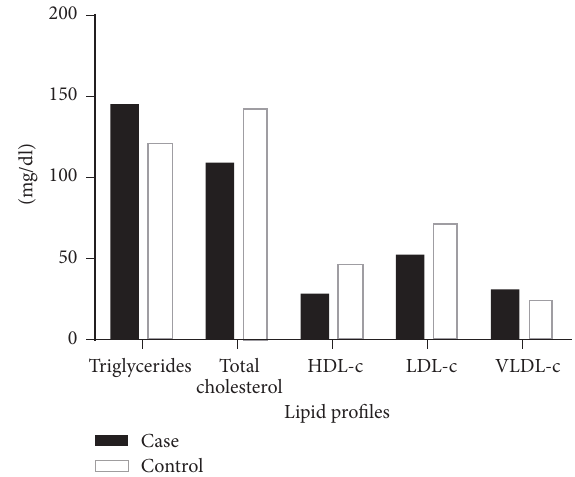
Figure2:Temporalevaluationoflipidprofilesofchildrenwithvivax